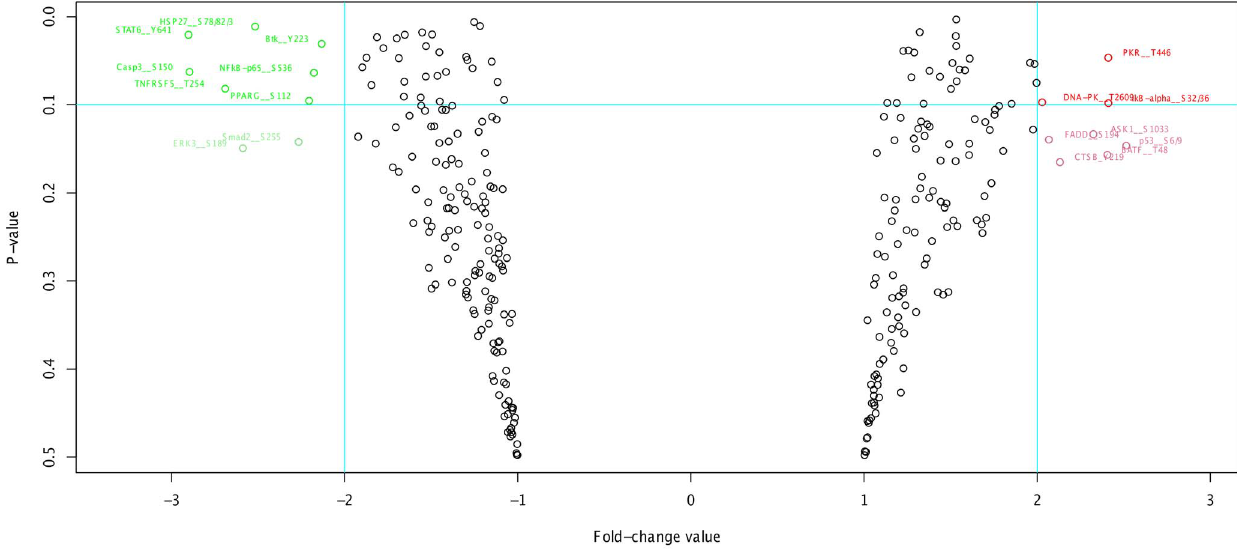
Figure 7. Example of a volcano plot generated using PIIKA 2. Points for which FC § 2 and P-value ƒ 0 : 1 are coloured red, while those with FC § 2 but P-value v 0 : 1 are pale red; Similarly, points with FC ƒ { 2 and P-value ƒ 0 : 1 are green, while those with FC ƒ 2 but P-value v 0 : 1 are pale green. All other points are coloured black. The horizontal and vertical blue lines represent the P-value and FC cutoffs, respectively. All coloured points are accompanied by labels showing to which peptide the point corresponds.